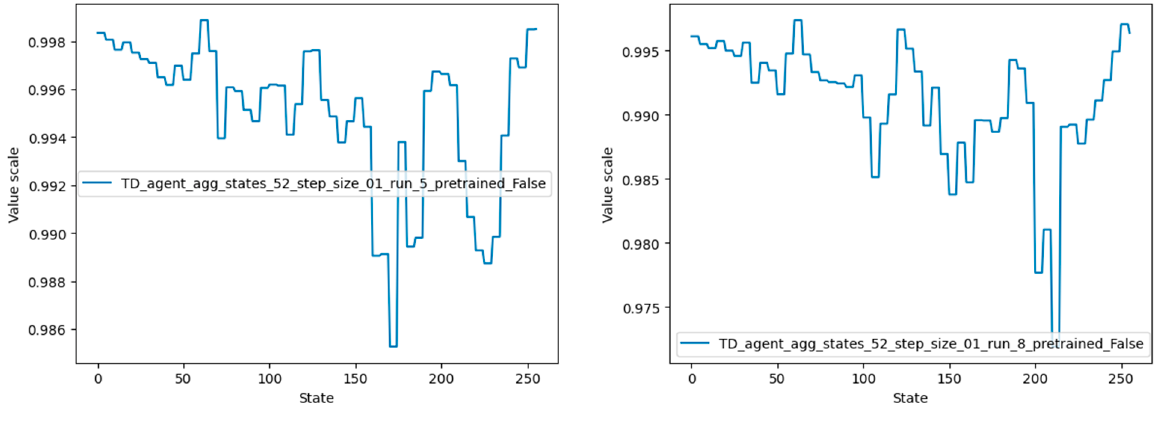
Figure 16. State-value plots for the best-performing agents.